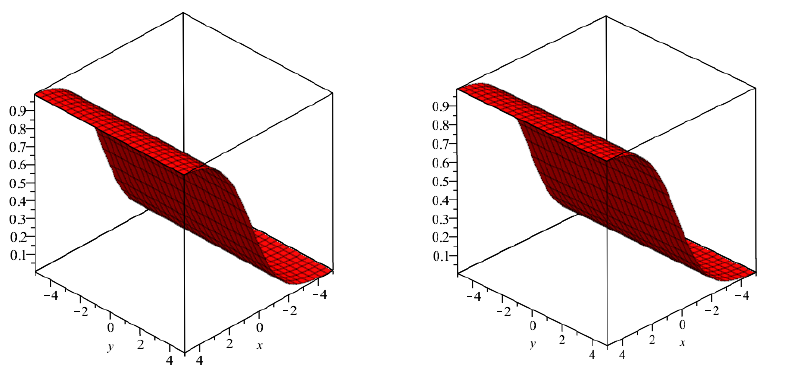
Figure 1. Behavior of the exact and analytical solutions for problem 1 at β = 1.